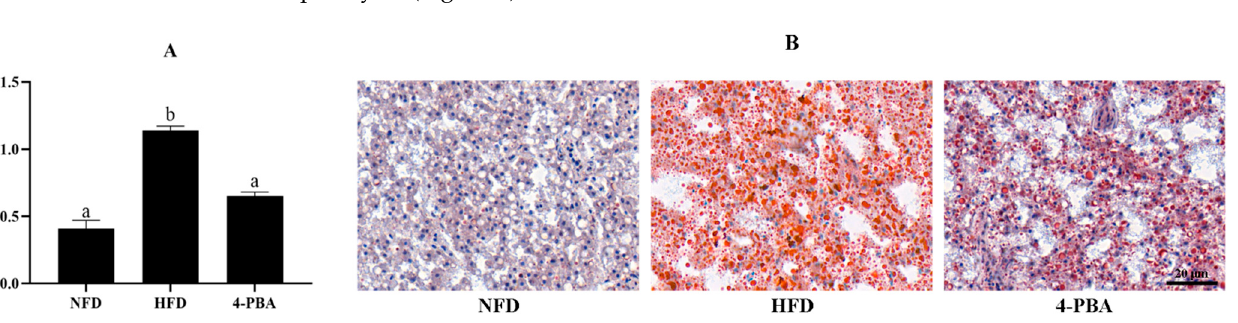
Figure 1. Weight gain ( A ) and feed efficiency ( B ) of spotted seabass ( L. maculatus ) that were fed the test diets for eight weeks. All values are exhibited as mean ± SE. The values with different super- scripts (a, b) are significantly different at p < 0.05 (Tukey’s test). Weight gain = final body weight / in- itial body weight; Feed efficiency = wet weight gain/dry feed fed.